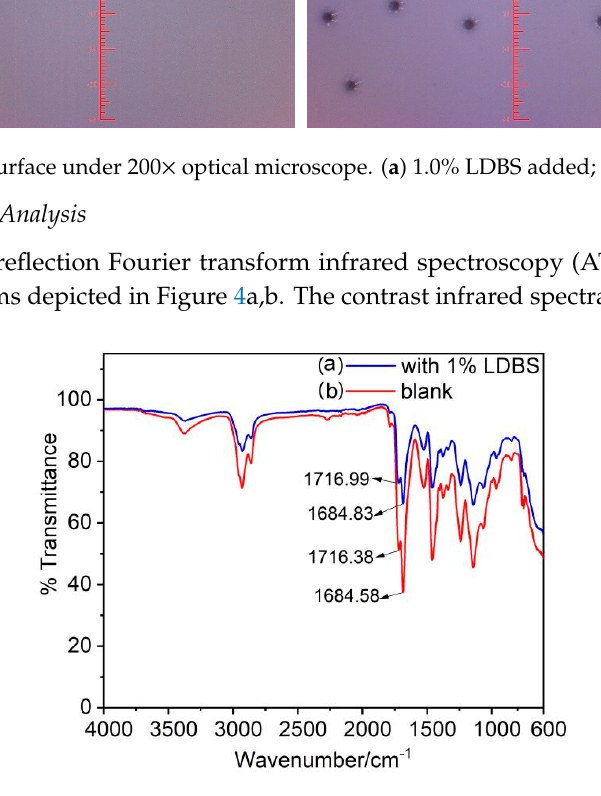
Figure 5. Comparison of the effect of LDBS addition on the infrared spectrum of coating film. ( a ) blue with 1.0% LDBS; ( b ) red without LDBS.